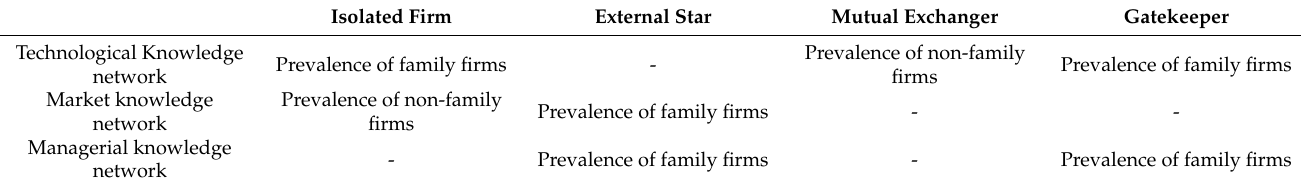
Table 7. Cognitive roles for family and non-family firms: summary of results by knowledge